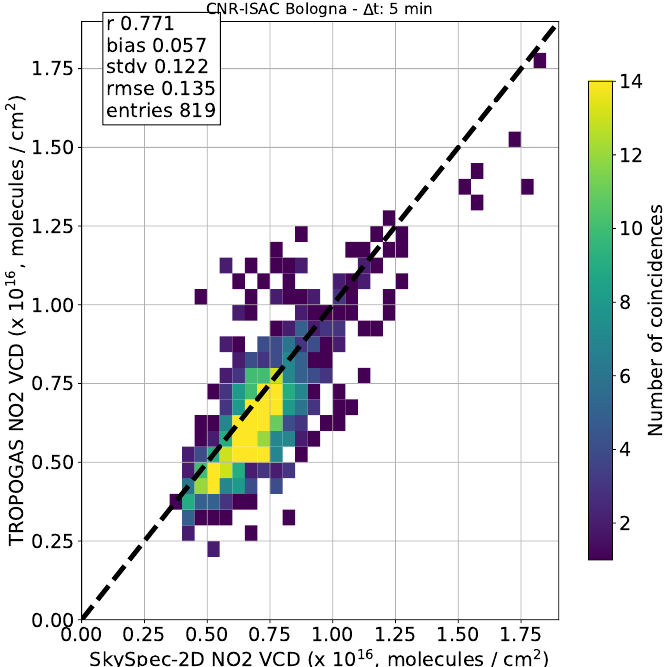
Figure 6. Scatterplot of NO 2 VCDs retrieved from TROPOGAS and SkySpec-2D during the Bologna inter-comparison campaign and averaged in 5 min intervals.